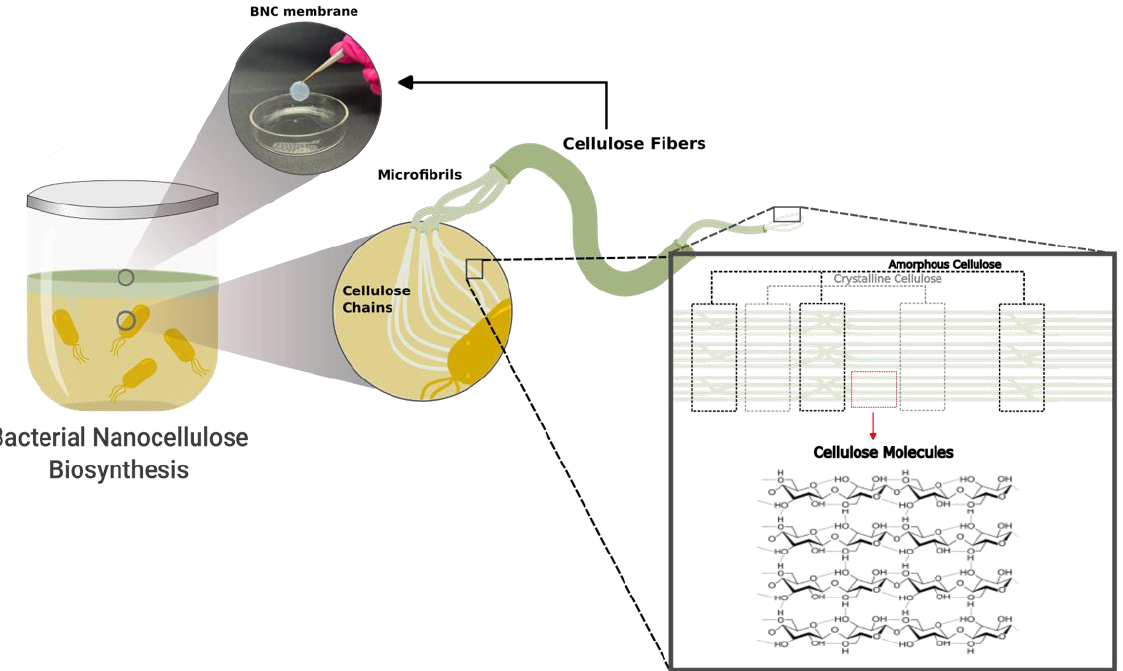
Figure 1. Representation of cellulose structure interconnected by a hydrogen bond. The cellulosic membrane exhibits different structures at different scales: the cellulose fibers consist of bundles of elementary fibrils, and these fibrils are composed of parallel stacked molecular cellulose chains [67]. The exciting properties of cellulose result from its specific structure, however, its crystallinity, morphology, physicochemistry (density, hydrophilicity, porosity, etc.), and fiber dimensions can vary according to different polymer sources [61]. Thus, its interactions with other chemical substances are influenced by the modifications in the availability of its hydroxyl groups, which govern its chemistry [39,61,68]. Currently, these physical